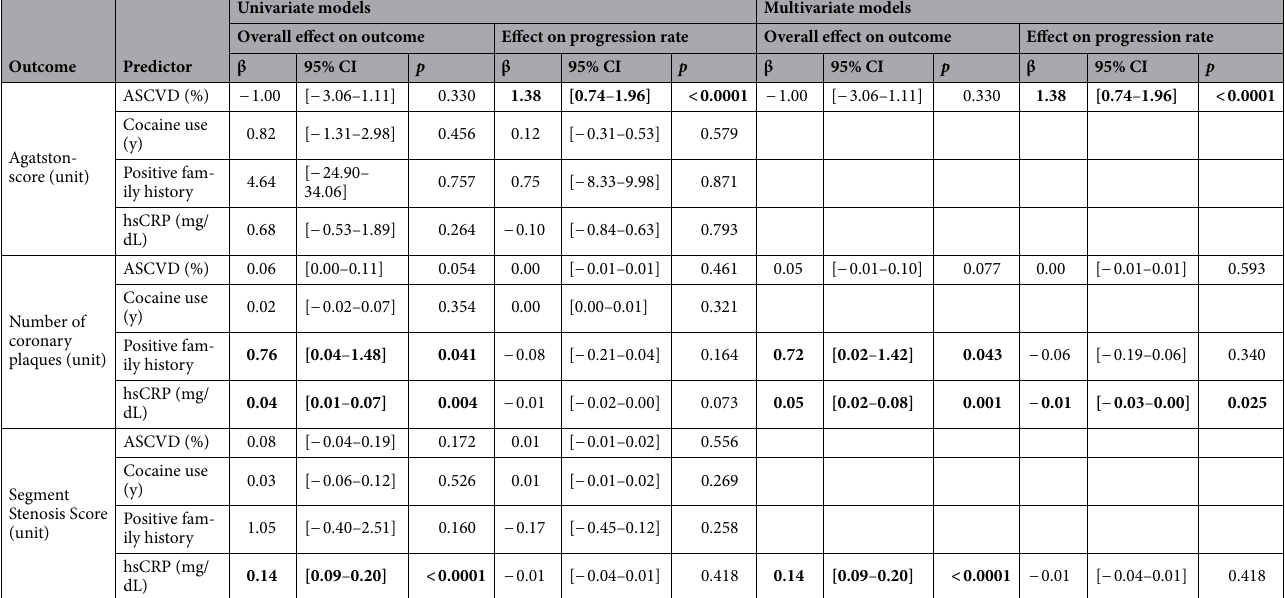
Table 4. Predictors of coronary artery disease outcomes among HIV-uninfected individuals. Abbreviations: β unstandardized beta coefficients from linear mixed model; ASCVD risk cardiovascular risk defined by the ACC/AHA Guideline on the Assessment of Cardiovascular Risk; CI confidence interval; HIV human immunodeficiency virus; hsCRP high ‐ sensitivity C ‐ reactive protein. p values smaller than 0.05 are indicated in